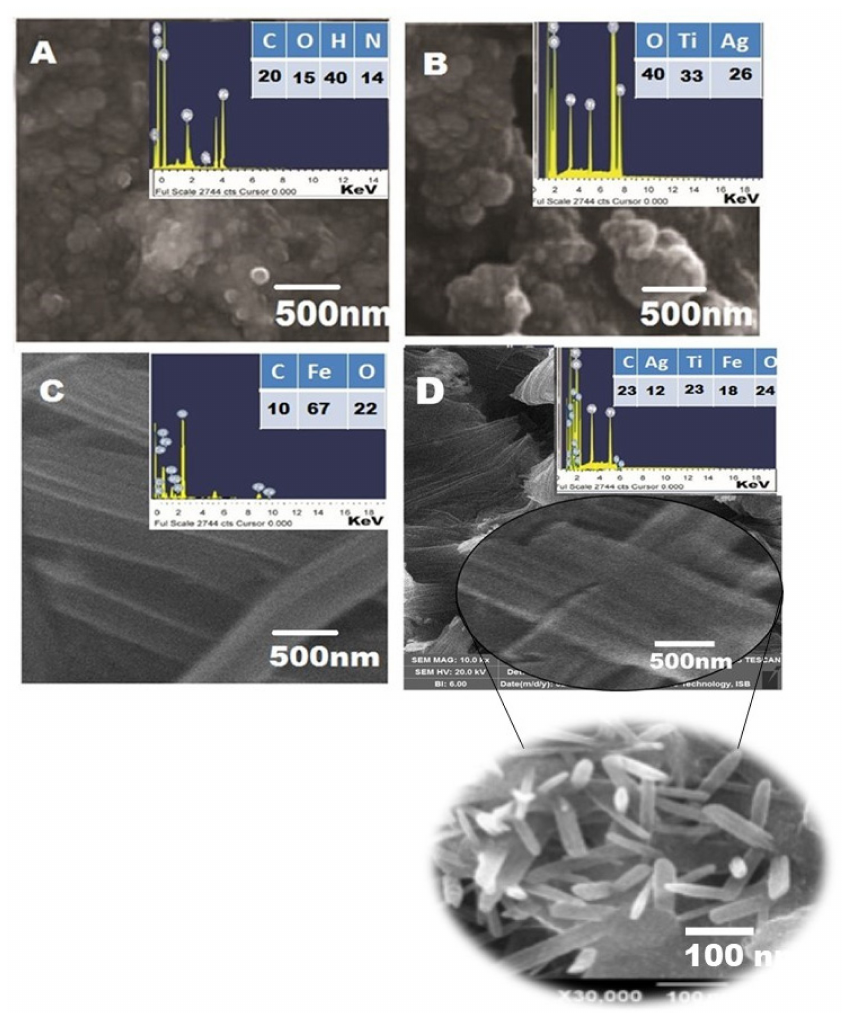
Figure 2. SEM and EDX spectra of synthesized nanomaterials. ( A ) Pure CS (spherical) NPs, ( B ) Ag/TiO 2 (spherical) nanohybrid, ( C ) Fe 2 O 3 nanorod-like structures, and ( D ) CIP- Ag/TiO 2 /Fe 2 O 3 /CS (nanorod-shaped) nanoformulation (NDDS). Scale bar is mentioned. Nanorods were confirmed at higher indicated